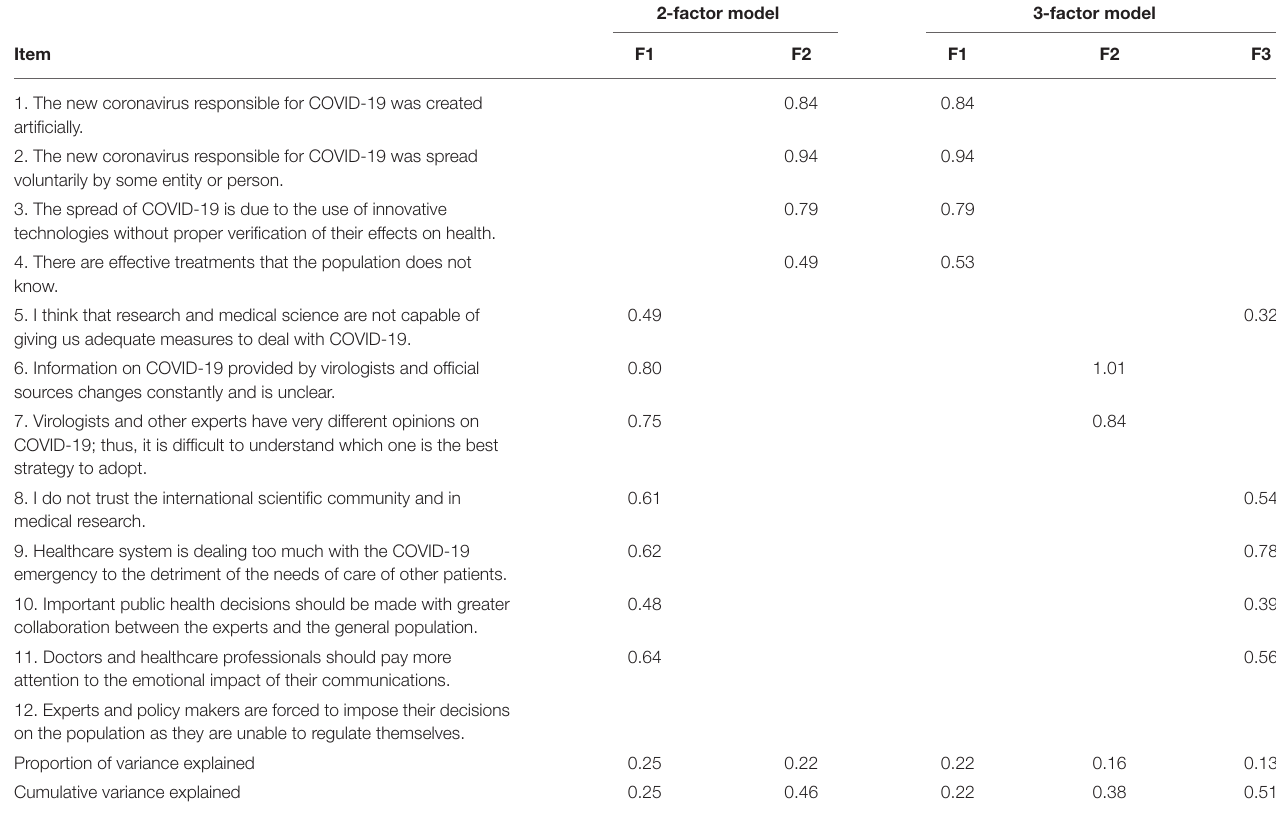
TABLE 2 | Exploratory factor analysis results: oblimin-rotated factor loadings and explained variance for the two alternative